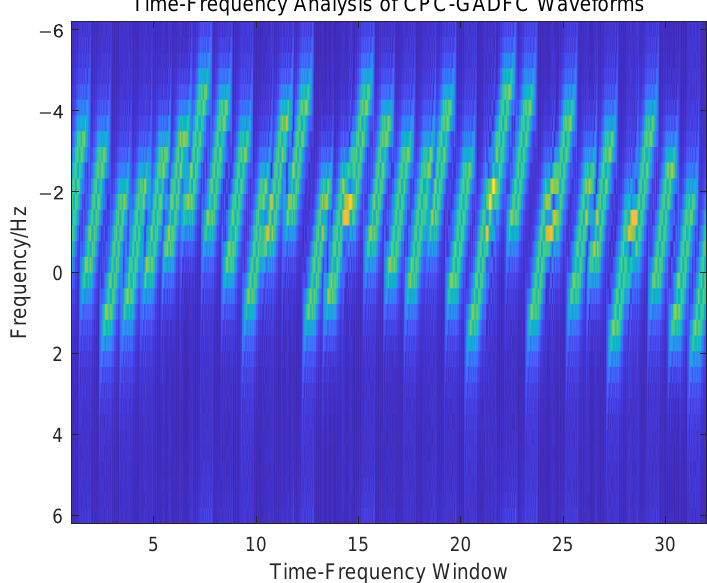
Figure 11. Time -Frequency Analysis of CPC-GADFC